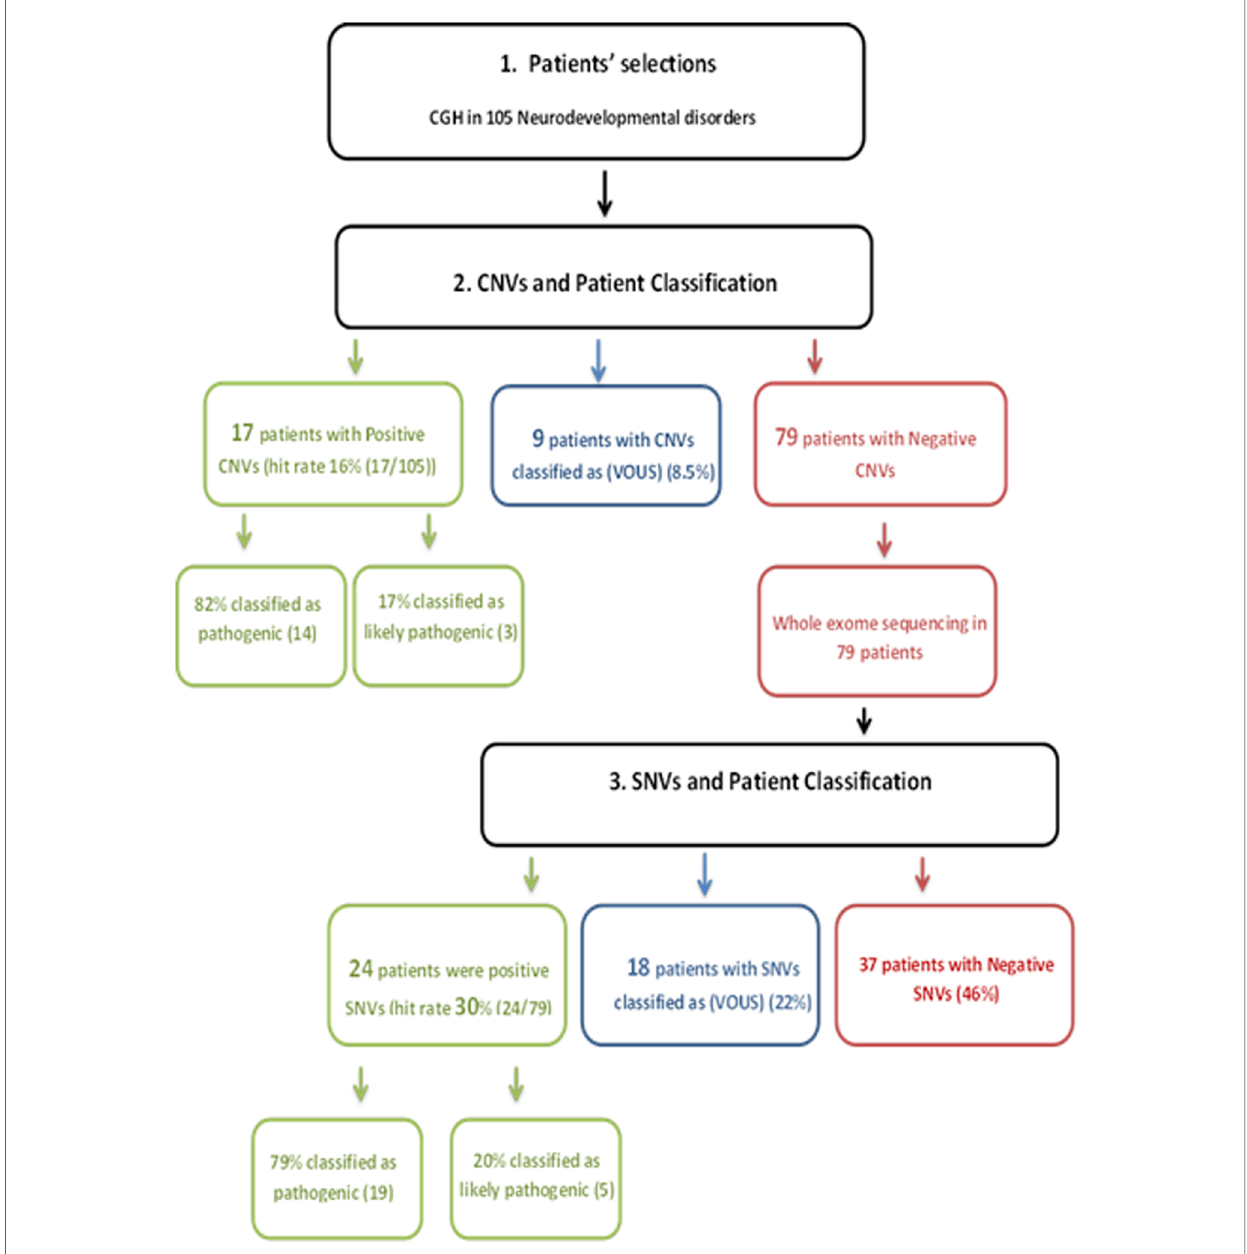
FIGURE 1 Flowchart of the process followed in this study: 105 patients with age range from 1 month to 19 years diagnosed with specialist investigated through CGH and/or WES, 16% was the hit rate of CNVs. 82% of positive CNVs were classi fi ed as pathogenic and 17% were classi fi ed as likely pathogenic; 79 patients out of 105 were CNV negative and WES was subsequently requested for those patients. Twenty-four patients out of 79 were positive as pathogenic or likely pathogenic SNVs. The hit rate of SNVs was 30%; 79% were classi fi ed as pathogenic and 20% as likely pathogenic. A variant of uncertain signi fi cance was reported in 27 patients; 9 patients were classi fi ed to have CNVs and the rest 18 patients have SNVs. CGH, comparative hybridization; WES, whole exome sequencing; CNVs, copy number variations; SNVs, single-nucleotide